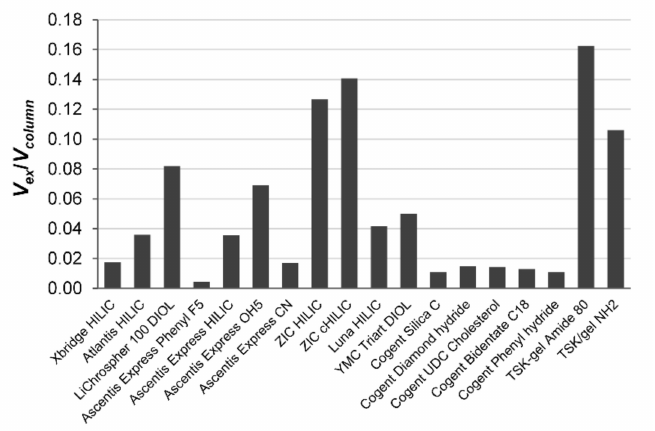
Figure 3. The volume ratios of the adsorbed layer of water ( V ex ) and volume of the 18 polar columns ( V column